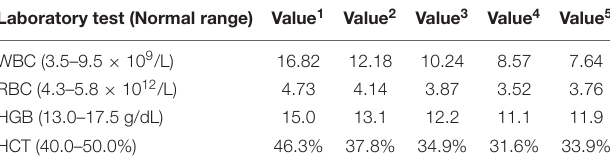
TABLE 1 | Labs during